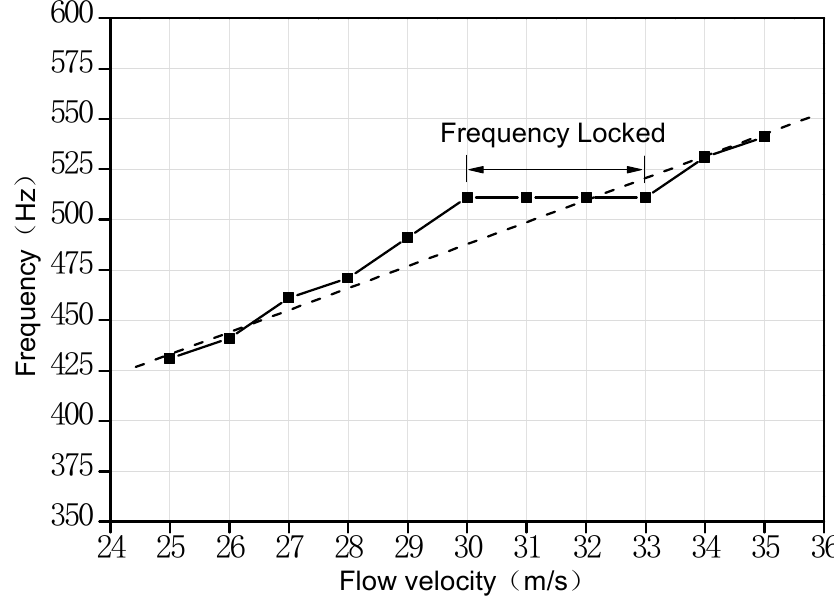
Figure 14. Variation law of sound pressure frequency under different flow velocities.